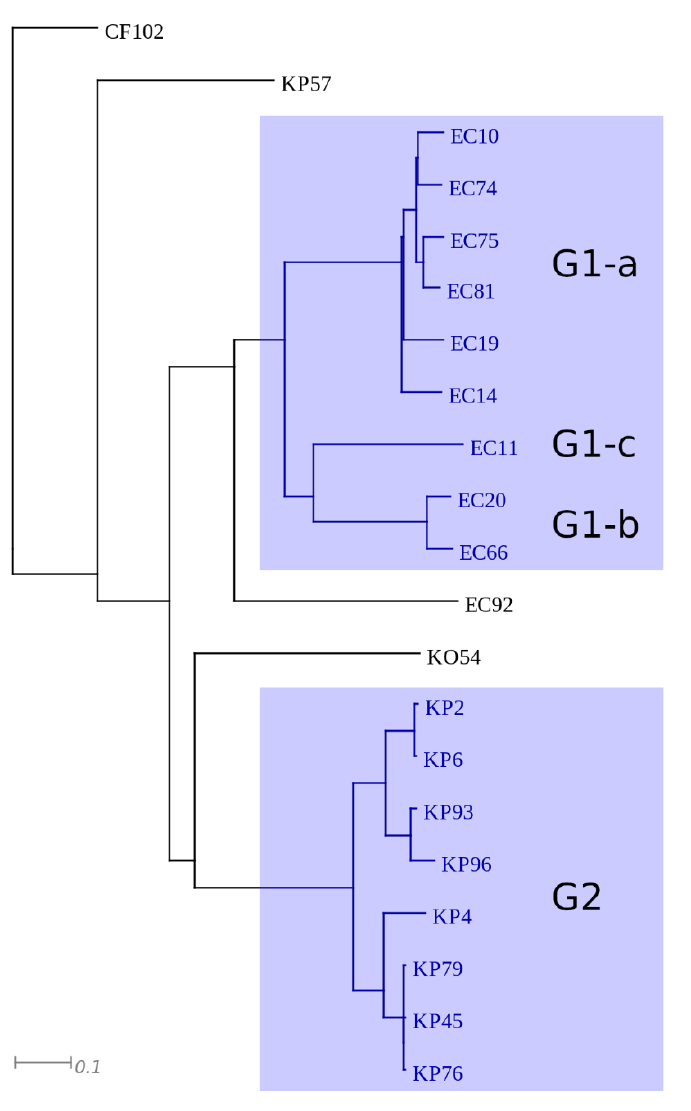
Figure 2. Representation of clusters based on MUMi distance of plasmid sequences. The major clusters are highlighted with blue.